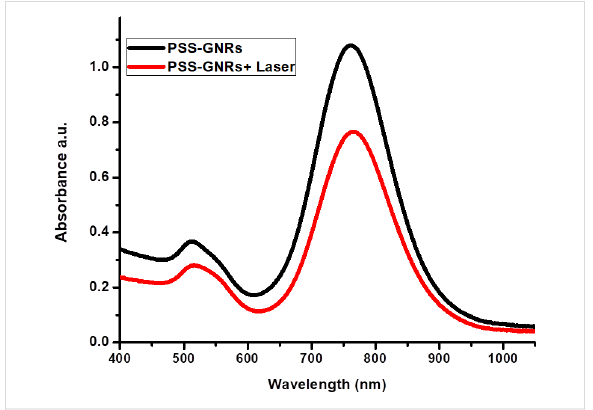
Figure 2: PSS-GNRs before and after 808 nm laser exposure, the LSPR peak shifted about 4 nm.